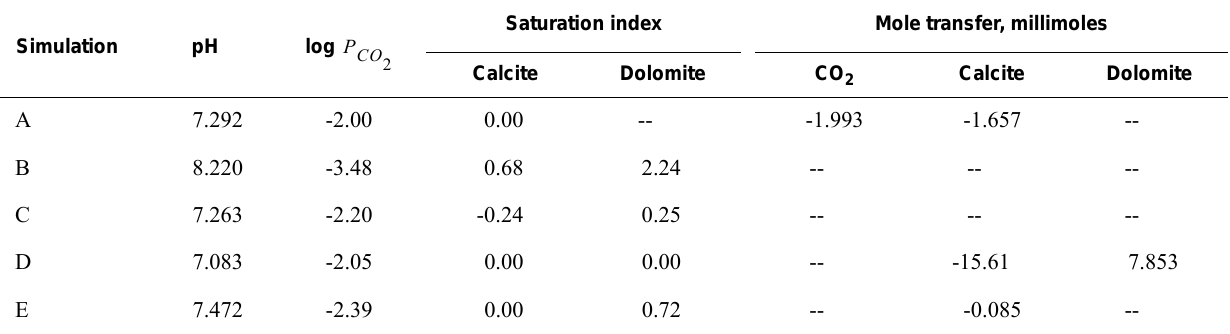
Table 16. Selected results for example